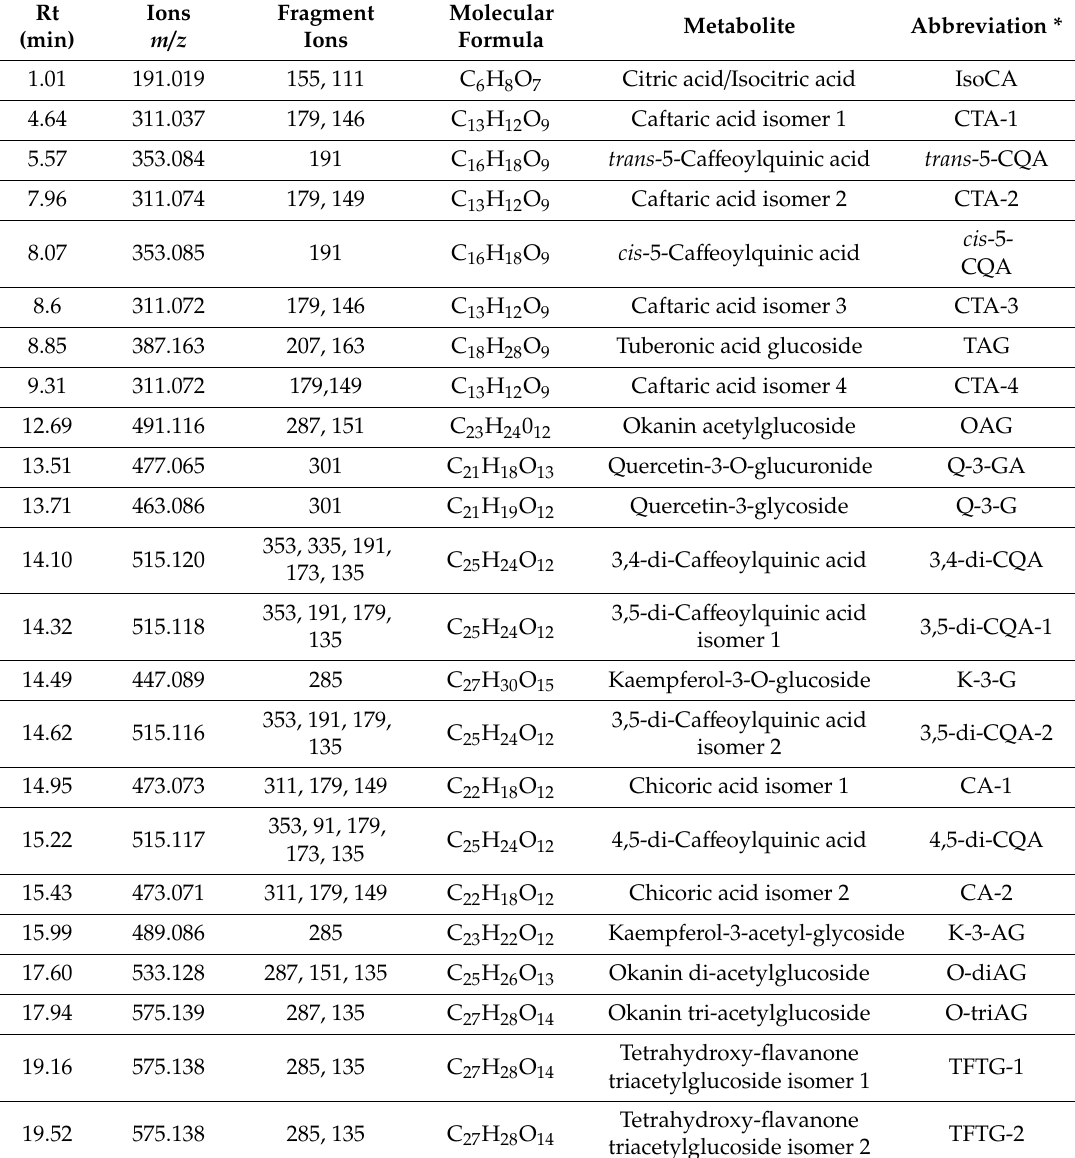
* Metabolite abbreviations relate to those of Figure 4 where relative intensities of metabolites are presented in a heat map